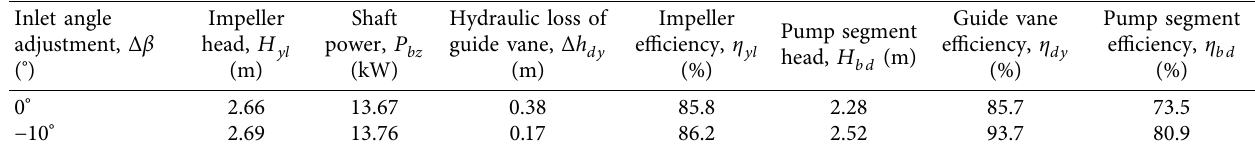
Table 3: Comparison of energy performance for the pump with Δ β � 0 ° and Δ β � − 10 °